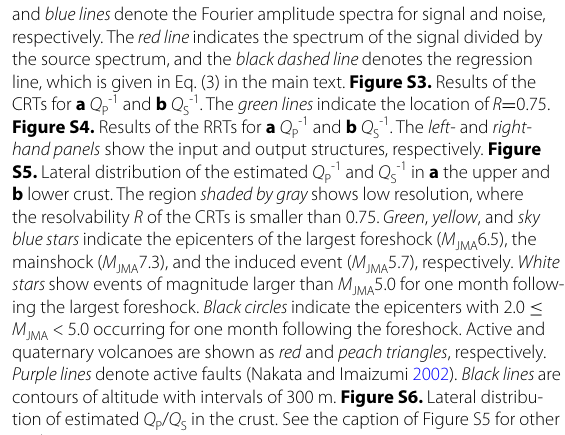
Purple lines denote active faults (Nakata and Imaizumi 2002). Black lines are contours of altitude with intervals of 300 m. Figure S6. Lateral distribu- tion of estimated Q P / Q S in the crust. See the caption of Figure S5 for other